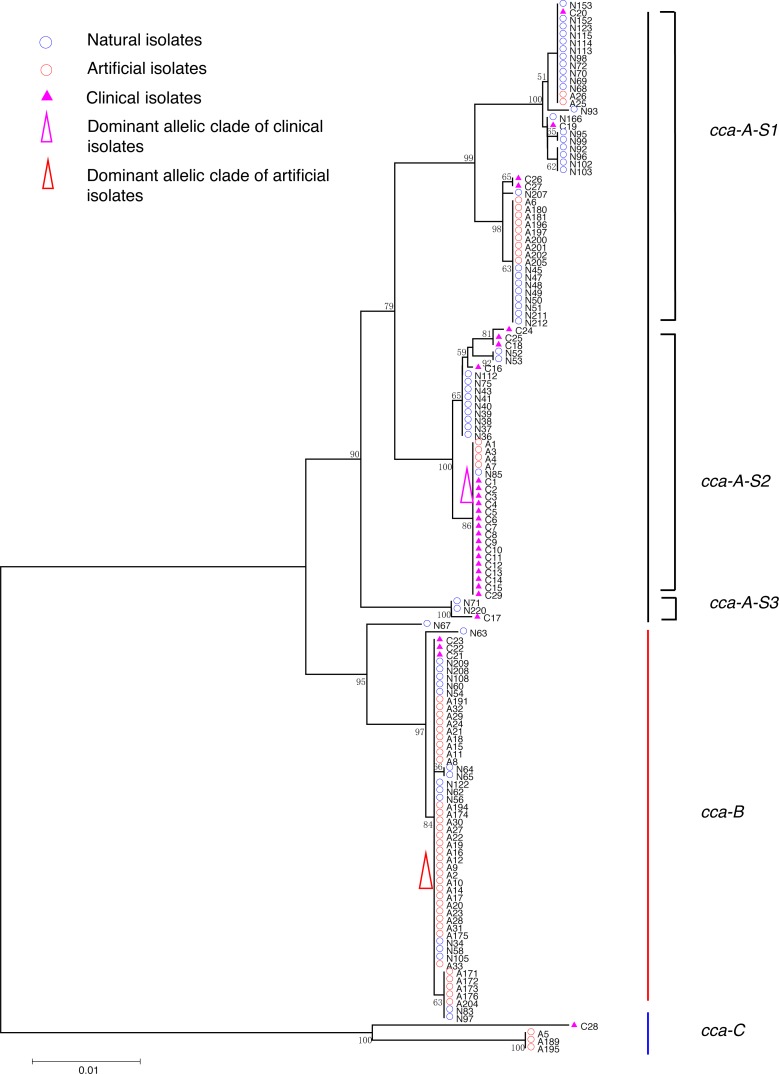
Neighbor-Joining tree of L. pneumophila isolates from DNA sequences of cca locus.Strain types, source natures and geographic locations of these isolates were shown in Table S1. Bootstrap support values (1,000 replicates) for nodes higher than 50% are indicated next to the corresponding node. Three main groups of the clades could be found.